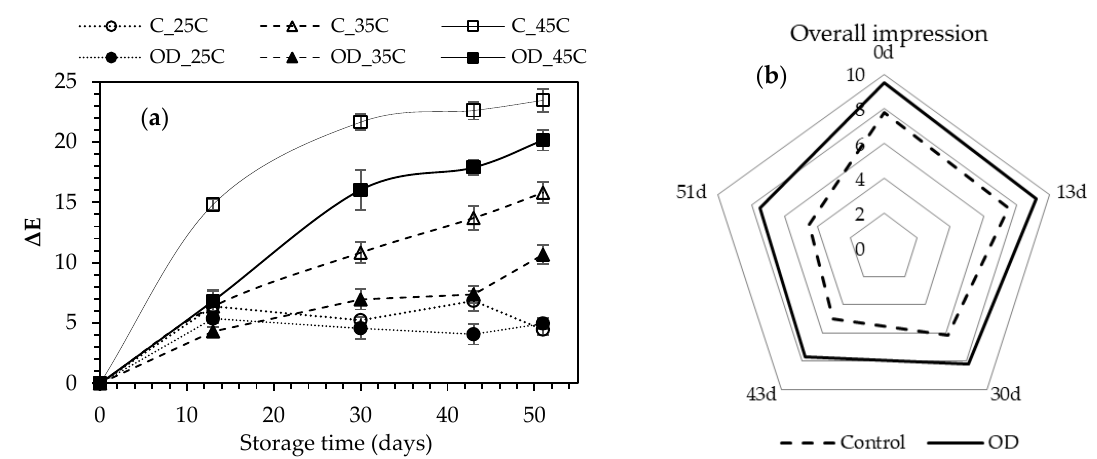
Figure 6. ( a ) Color change (Δ Ε ) and ( b ) Overall impression for the control and OD-pretreated air-dried fig halves during storage at 25 °C, 35 °C and 45 °C. Error bars represent standard deviation from multiple replications of treatments.